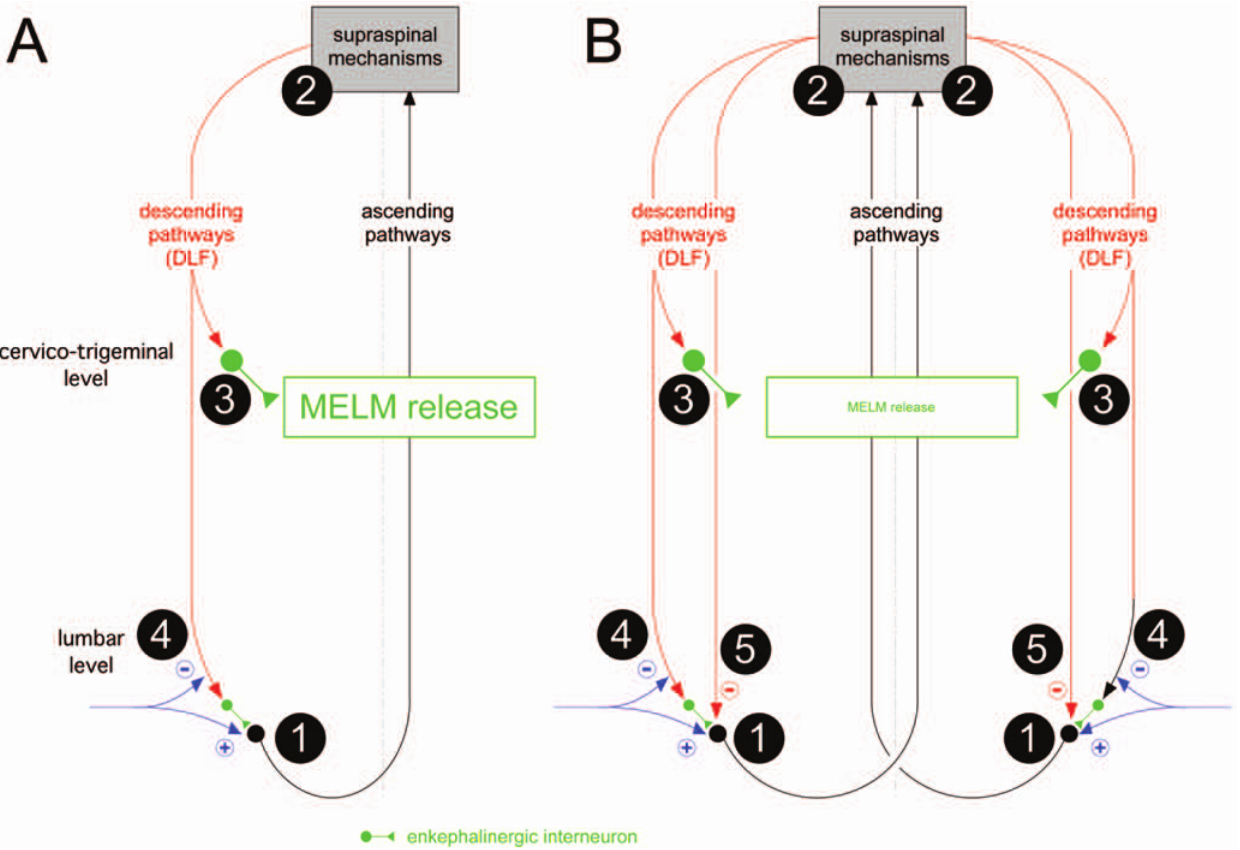
Figure 2. Hypothetical pathways regulating MELM release elicited by noxious mechanical stimuli. A. Stimulus applied on a single area. The peripheral input (blue) activates dorsal horn neurons (1) that project to the brain. Descending controls are triggered (2) that produce a series of influences on dorsal horn neurons through the DLF. One of these triggers a diffuse release of Met-enkephalin (3). However, such a release is prevented by the blockade of afferent inputs at the segmental level (4) (see references 2 & 3). B. Stimuli applied to two body areas (e.g. right and left paws). Identical processes are triggered from each stimulation site (1, 2, 3, 4) but the power of DNIC is strong enough to produce a functional block of firing as early as the dorsal horn